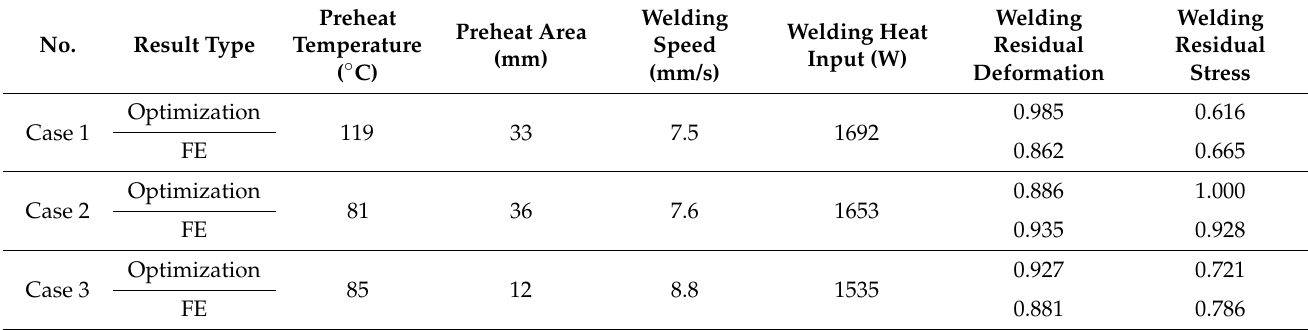
Table 6. Optimal compromise solution of two-objective optimization models.